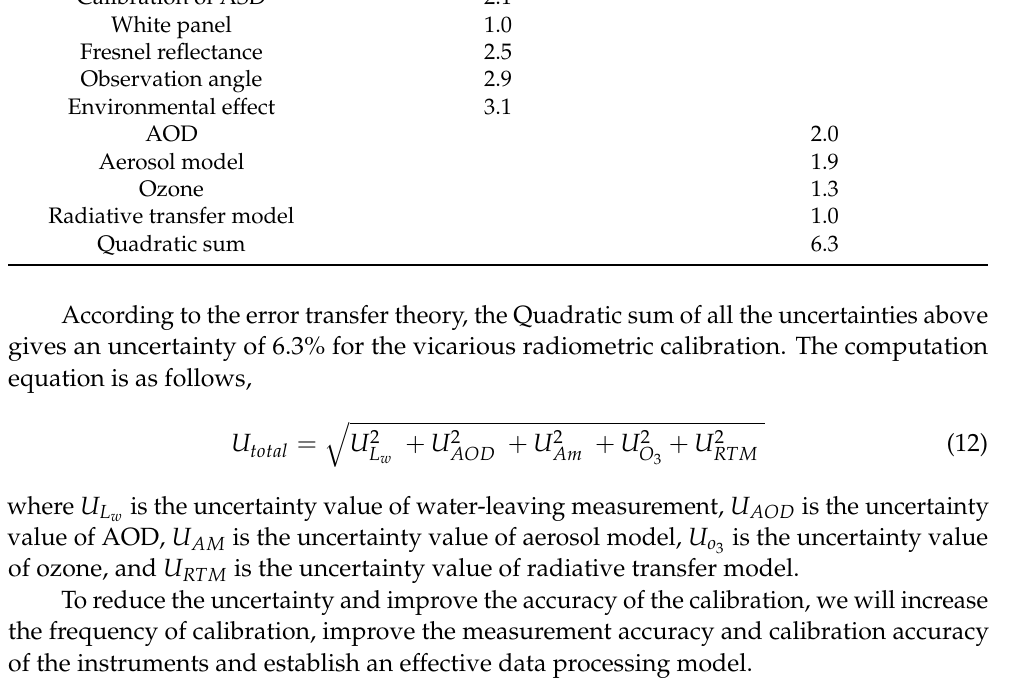
Table 11. Uncertainty of vicarious calibration for FY-3D/MERSI-II. Source Uncertainty/(%) Total Uncertainty/(%) Water-leaving measurement 5.4 Calibration of